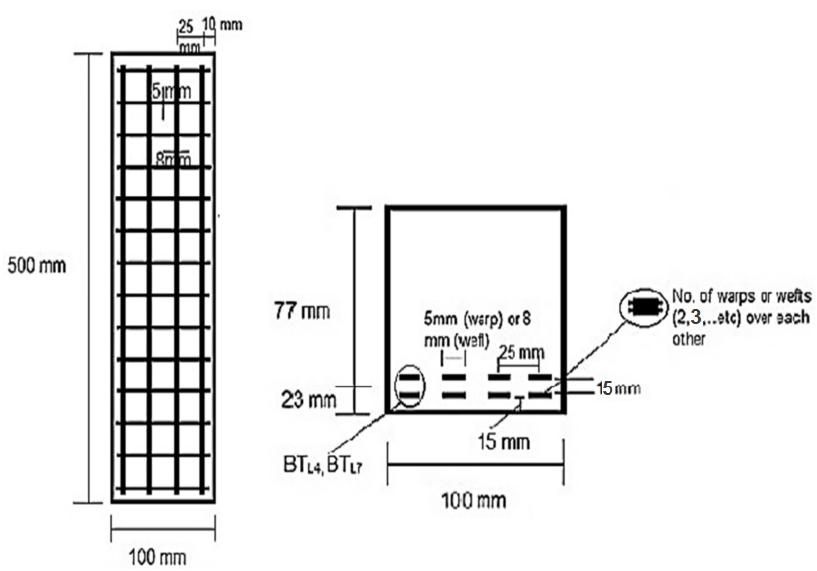
Figure 4. The arrangement of textile fibres in weft direction of small-scale TRC